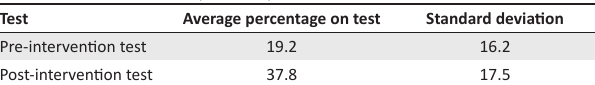
TABLE 2: Results from the pre- and post-intervention attainment